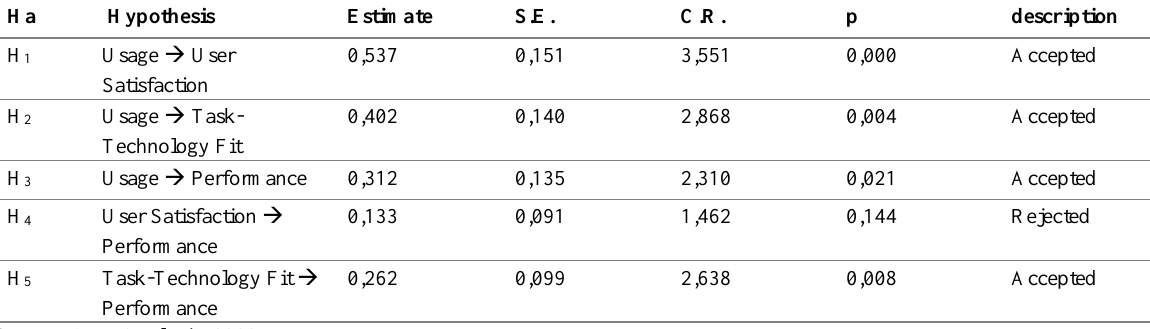
Table 2: Regression Weight Influence between